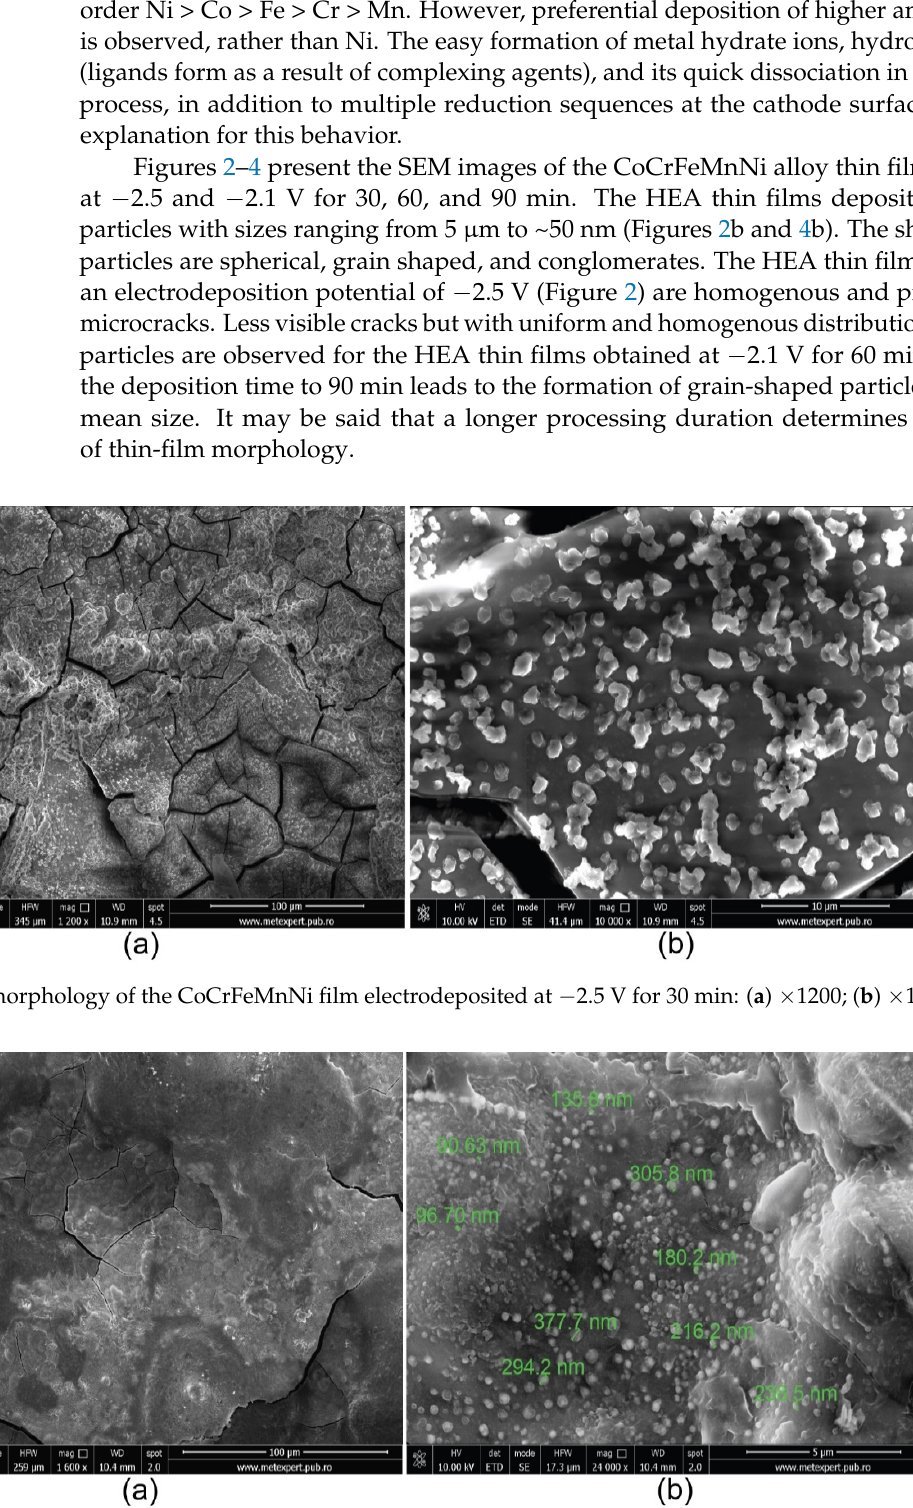
Figure 4. SEM morphology of the CoCrFeMnNi film electrodeposited at −2.1 V for 90 min: ( a ) ×1200; ( b ) ×80000. From these SEMs, one can observe that the number of the wheat grain formations increases with the decrease in the deposition potential and increase in the process dura- tion. The particles that form the high-entropy alloy film are functions of the variation in the electrodeposition potential and deposition time. The optimal value for the electro- deposition potential is −2.1 V. This is concluded from the SEM images and chemical compositions in Table 2. Table 2. HEA thin films chemical composition for electrodeposition at different potentials for 30, 60, and 90 min. Deposition time min Potential V Chemical percentage at. % Co